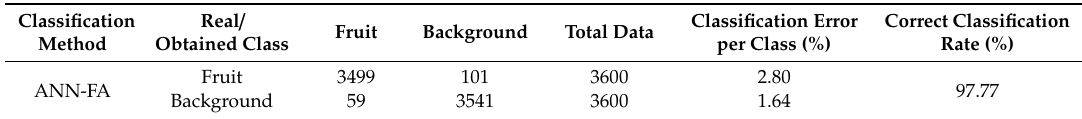
Table 8. Confusion matrices, classification error per class, and correct classification rate (CCR) in the best state of training of the hybrid ANN-FA classifier for the testing data.